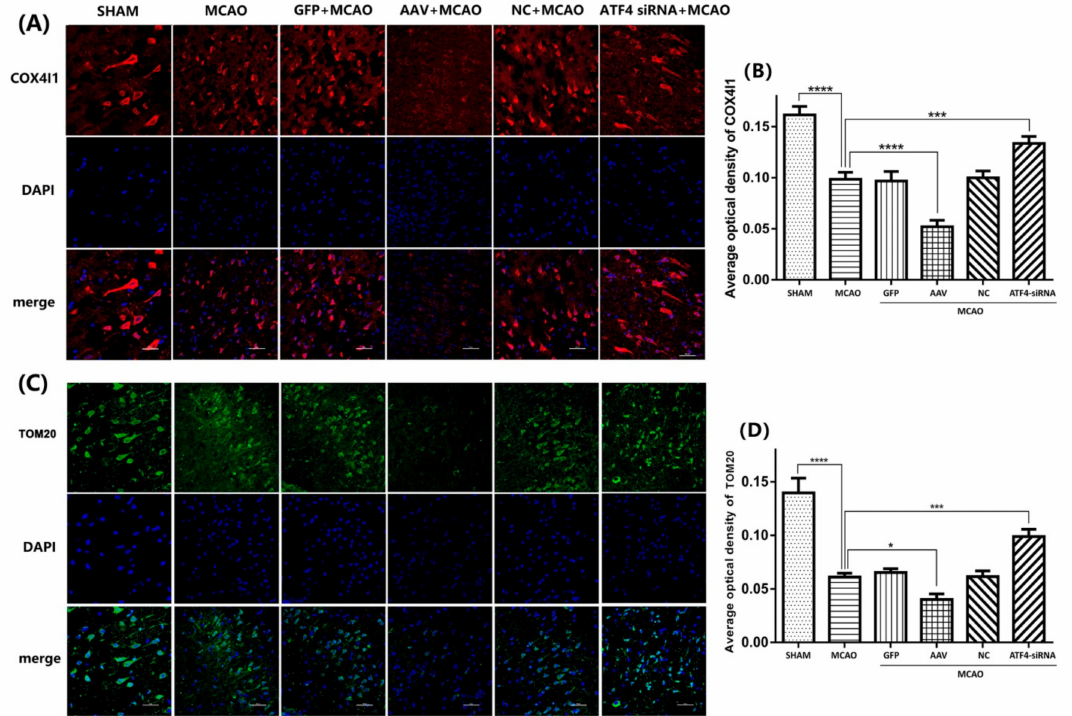
Figure 4. ATF4 decreases TOM20 and COX4I1 expressions in the cortex. ( A – D ) TOM20 and COX4I1 immunostaining resulted to be significantly reduced in the MCAO group compared to the sham group. The average optical densities of TOM20 and COX4I1 immunostaining resulted to be decreased or increased by AAV and ATF4 siRNA compared to the MCAO group. Error bars represent mean ± SD. (* p < 0.05, *** p < 0.001 and **** p < 0.0001 vs. indicated group). n = 5 in each group. MCAO, middle cerebral artery occlusion-reperfusion; GFP, green fluorescent protein; AAV, ATF4 overexpression adeno-associated virus; siRNA, small interfering RNA; NC, negative control